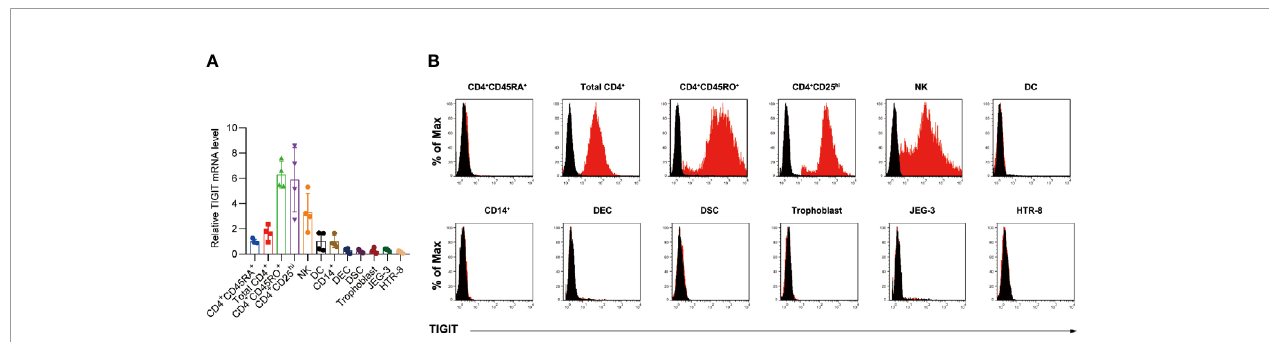
FIGURE 1 | Expression of TIGIT protein in decidual immune cells. (A) , qPCR of the expression of TIGIT mRNA in total CD4 + , CD4 + CD45RO + , CD4 + CD45RA + , CD4 + CD25hi, NK, DC, CD14 + monocyte/macrophages, decidual epithelial cells (DECs), decidual stromal cells (DSCs), trophoblasts, JEG-3, and HTR-8/SVneo cells relative to TIGIT expression in naive CD4 + CD45RA + cells. Data are mean ± s.d. of four independent biological replicates. (B) , Membrane-bound TIGIT expression in different subsets of immune cells. The expression of TIGIT on different human immune cells was detected by staining with the indicated antibody, followed by fl ow cytometry analysis. The histograms shown in black correspond to the isotype controls, whereas the red histograms indicate the positive fl uorescence ( n = 4 independent biological experiments with similar